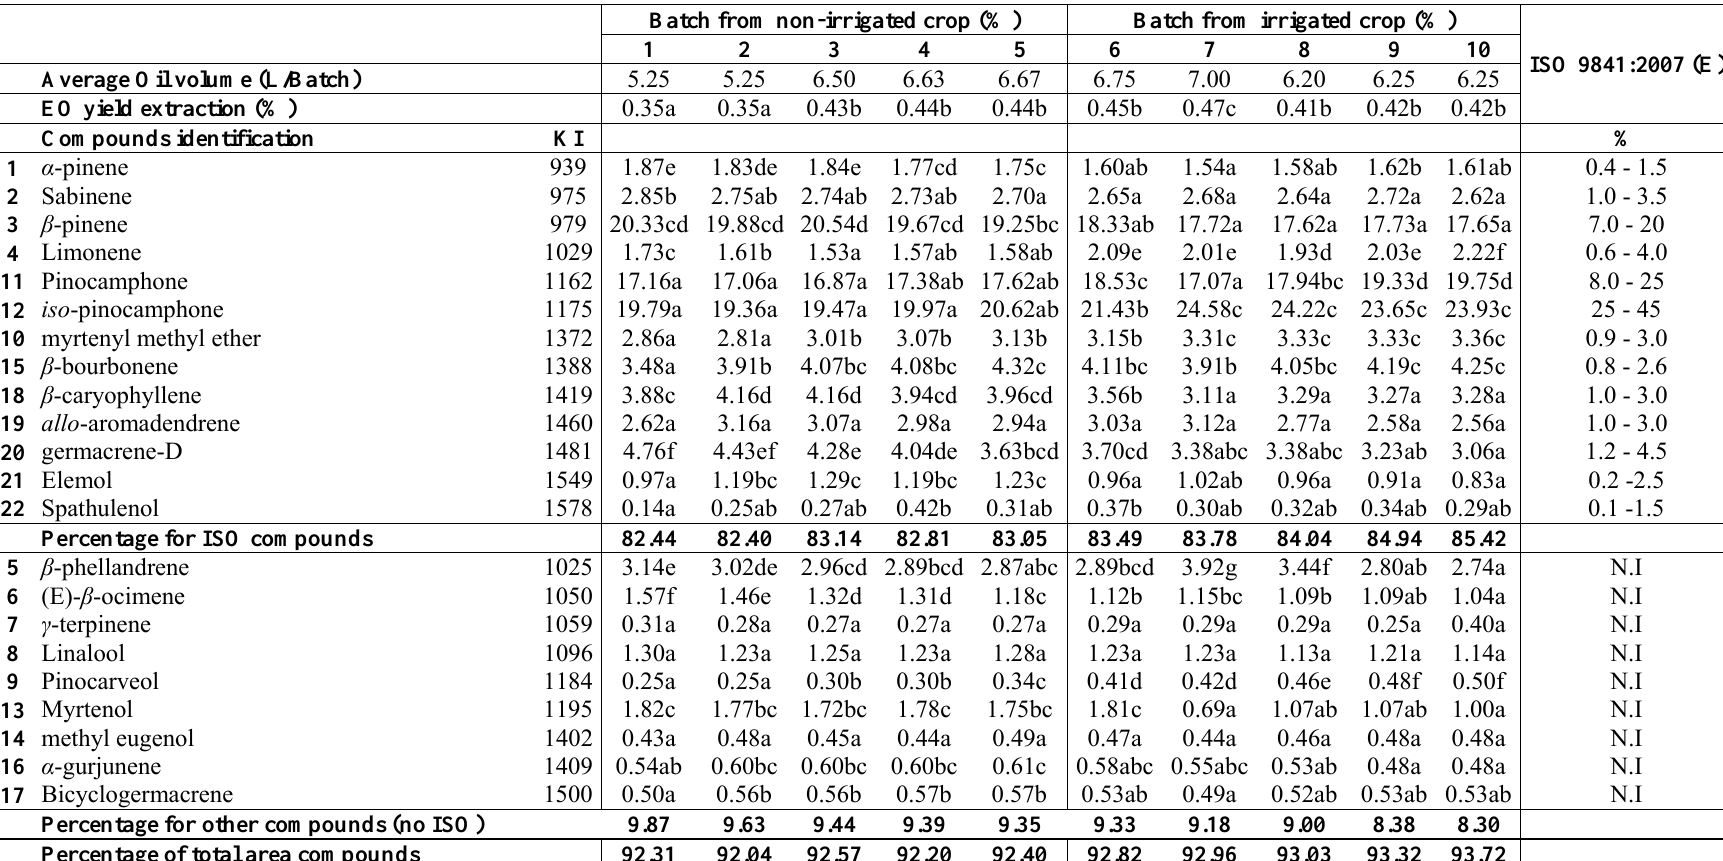
Table 1. Extraction yield (%) and volatile composition (% area) obtained for each type of studied conditions (non-irrigated and irrigated crop) in essential oil of H. officinalis